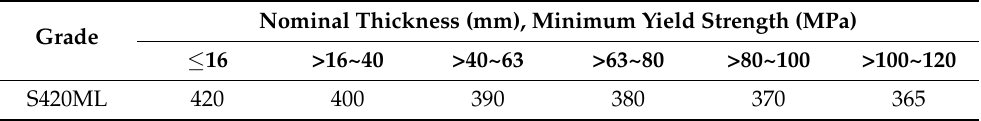
Table 3. S420ML tensile yield strength at room temperature.